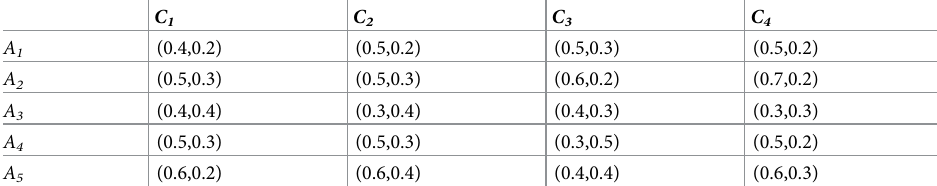
Table 3. The q -rung orthopair fuzzy decision matrix M 3 given by D 3 .